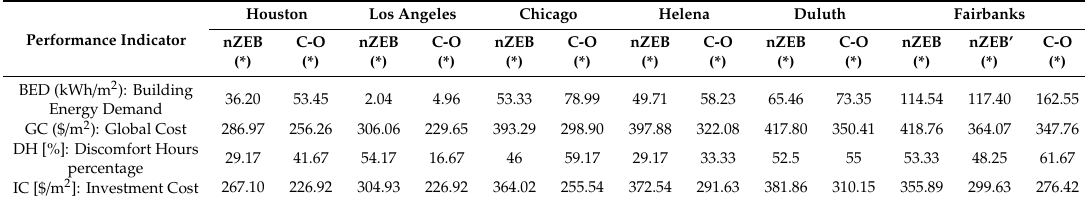
Table 14. Performance indicator of optimal